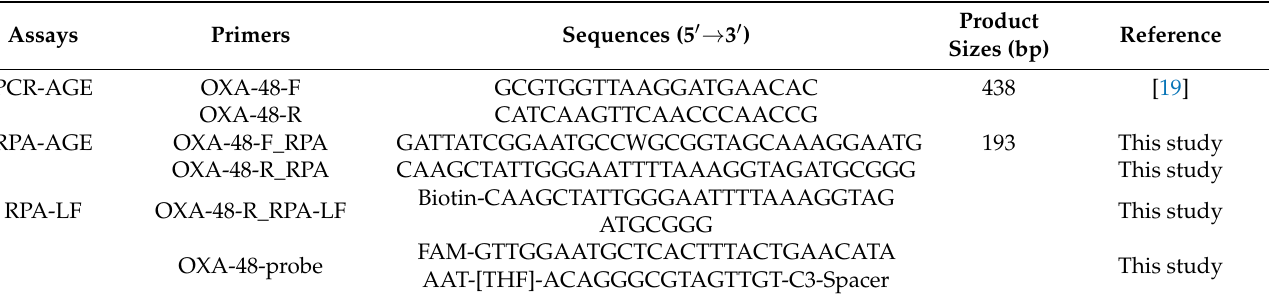
Table 2. Primers and probe used in this study for detection of the bla OXA-48-like